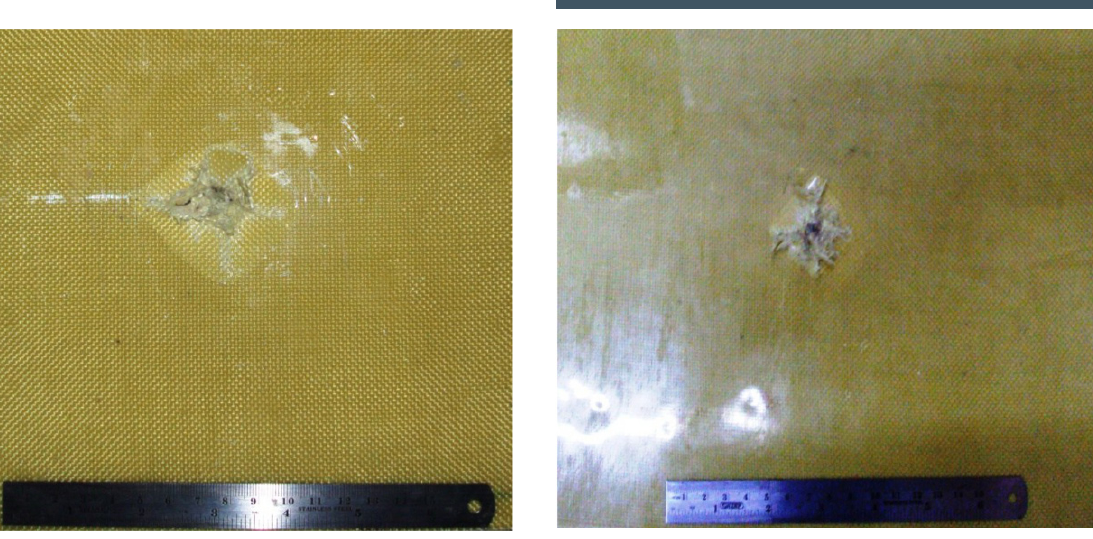
Figure 7. Damage at rear face of 0/90/45/-45 19 layer laminate.